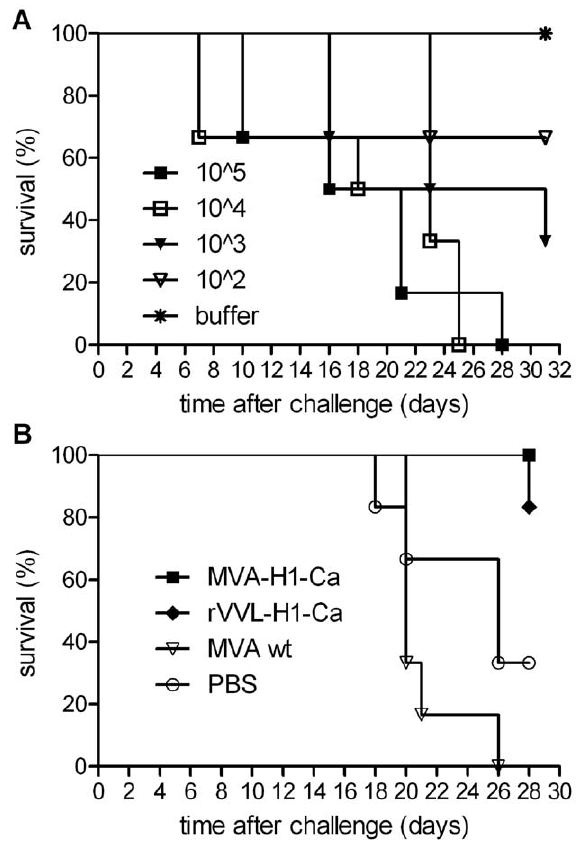
Figure 3. Survival of SCID mice after passive transfer of immune sera. A) Groups of three mice were infected intranasally with doses of H1N1 wild-type virus in the range of 10 2 to 10 5 TCID50 per animal and monitored over a 32 day period. The 10 4 and 10 5 doses were fully lethal. With the lower doses, mice survived the monitoring period. B) Passive transfer of mouse sera and challenge with a dose of 10 5 TCID50 of H1N1 wild-type virus. All SCID mice receiving the sera of Balb/c mice vaccinated with MVA-H1-Ca were protected, while the MVA-wt controls all died. doi:10.1371/journal.pone.0012217.g003 PLoS ONE |